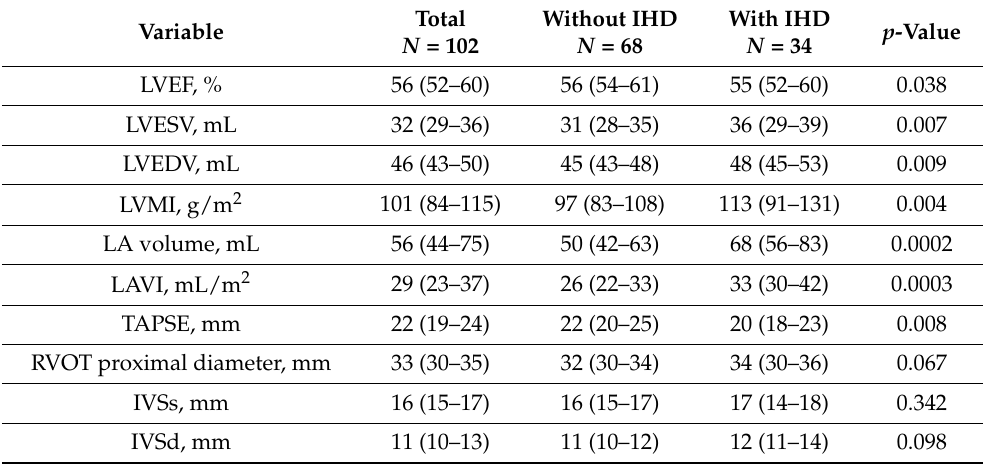
Table 3. Transthoracic echocardiographic